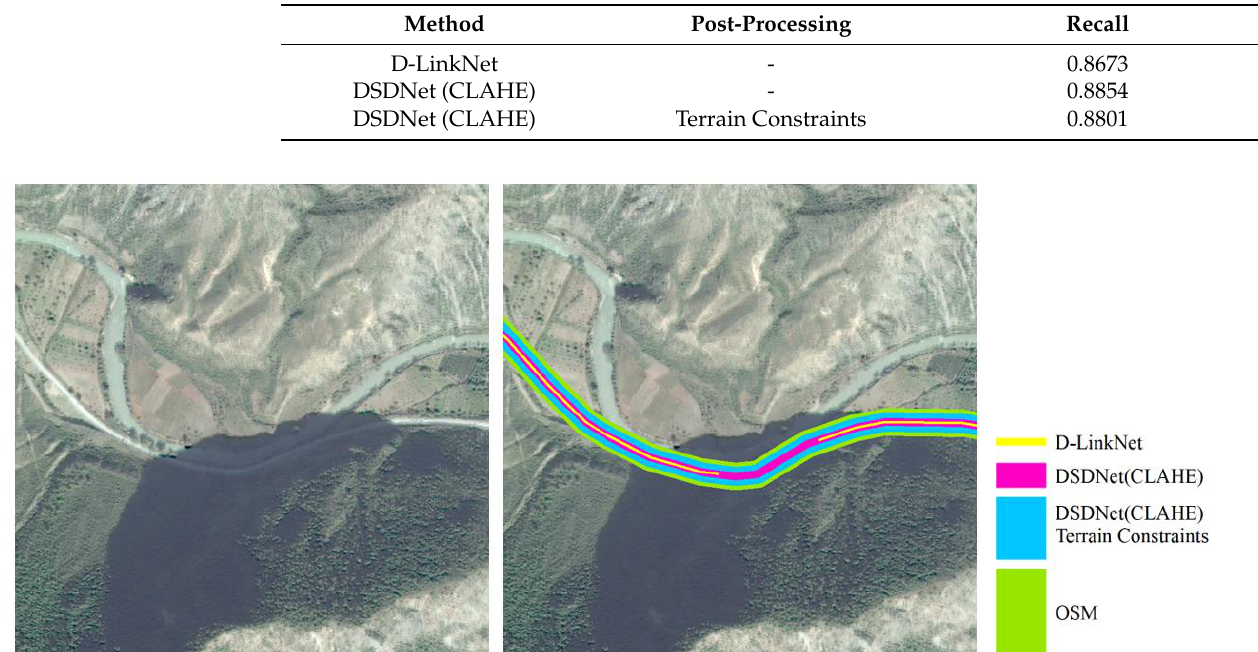
Figure 11. Diagram of the results for the complete region: ( a ) Optional image; ( b ) result of D-LinkNet; ( c ) result of DSDNet with CLAHE method—the image has not been processed with terrain constraints and ( d ) result of DSDNet with CLAHE method—the image has been processed with terrain constraints. Table 3. Accuracy of different experimental models.